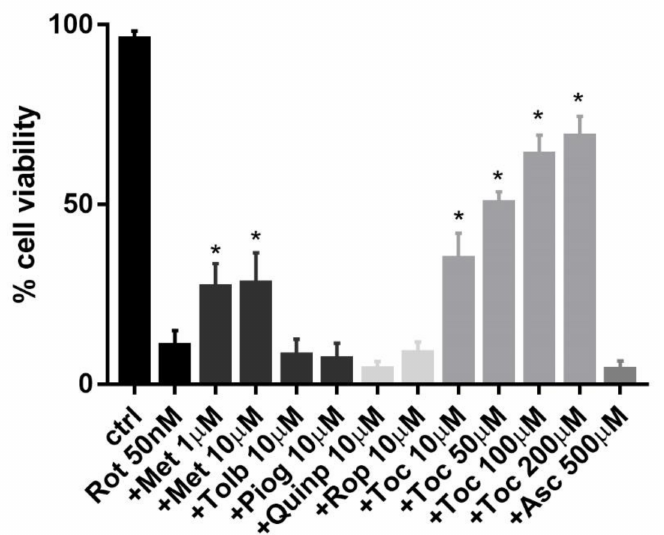
Figure 5. Protective effect of different compounds on rotenone-reduced INS-1 β -cells viability. Cell viability was assessed after 24 h exposure to rotenone 50 nM, with or without the presence of several compounds belonging to different classes of drugs with putative protective characteristics. Data are expressed as mean ± SEM of three independent experiments. * p < 0.05 compared to rotenone 50 nM, ANOVA, Dunnett’s post hoc